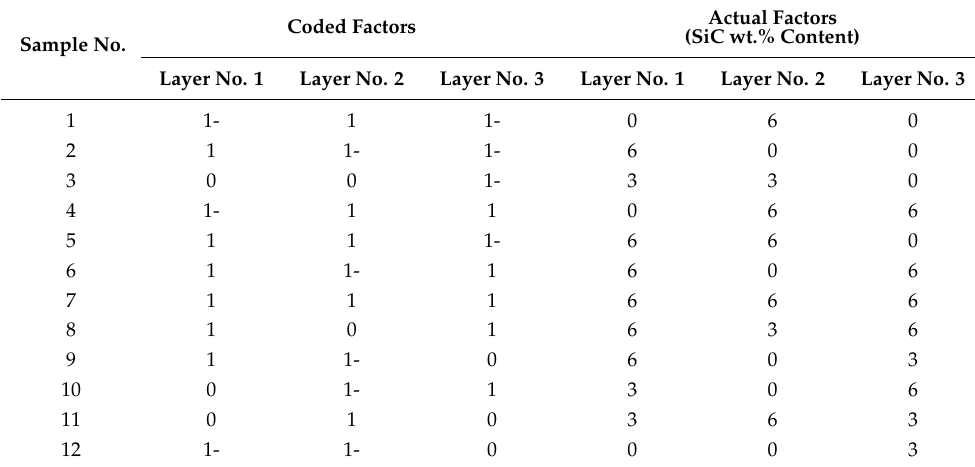
Table 2. Experimental design matrix of different compositions.